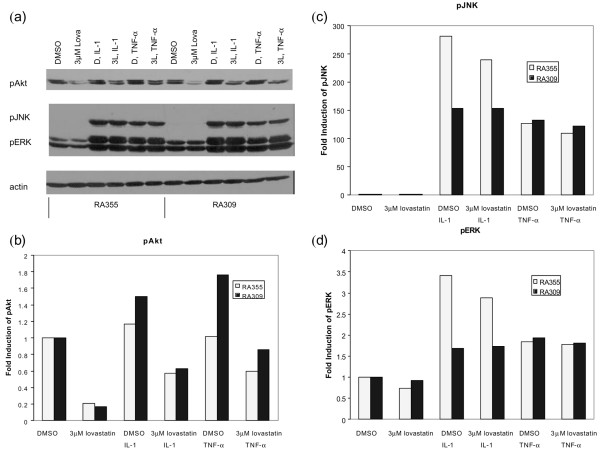
The steady-state and activated Akt pathway is affected by lovastatin. Rheumatoid arthritis synovial fibroblasts (2 lines shown) were cultured in the presence of 3 μM lovastatin or DMSO (solvent control) for 48 hours. They were then treated with 2 ng/ml IL-1 or 10 ng/ml tumor necrosis factor-α (TNF-α) for 15 minutes. (a) Cellular lysates were prepared, subjected to 12% PAGE and analysed by immunoblotting for pAkt, pJNK, pERK and actin. D, dimethylsulfoxide (DMSO); 3L, 3 μM lovastatin; D, IL-1, cells cultured with DMSO then induced with IL-1; D, TNF, cells cultured with DMSO then induced with TNF-α; 3L, IL-1, cells cultured with 3 μM lovastatin then induced with IL-1; 3L, TNF, cells cultured with 3 μM lovastatin then induced with TNF-α (b-d) Bands were quantified by UN-SCAN-IT and corrected for loading by actin (b) pAkt, (c) pJNK, (d) pERK.